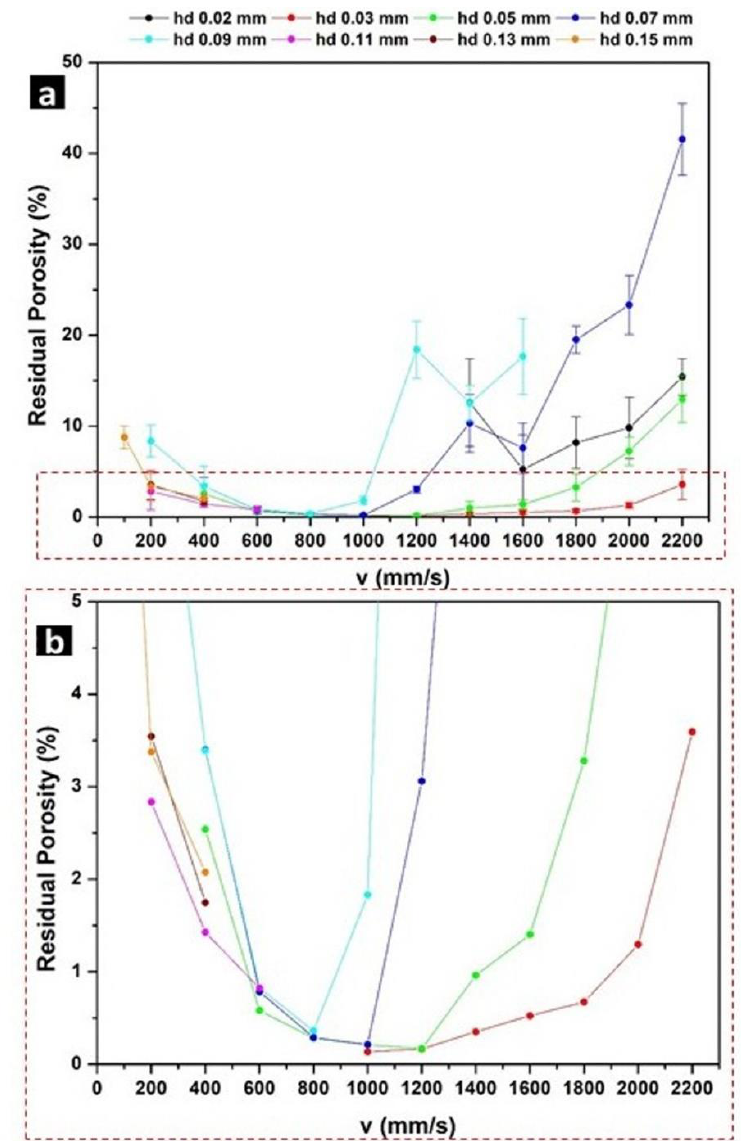
Figure 6. ( a ) Effect of scanning speed and hatching distance on the porosity level; ( b ) Zoom of the porosity level lower than 5%.